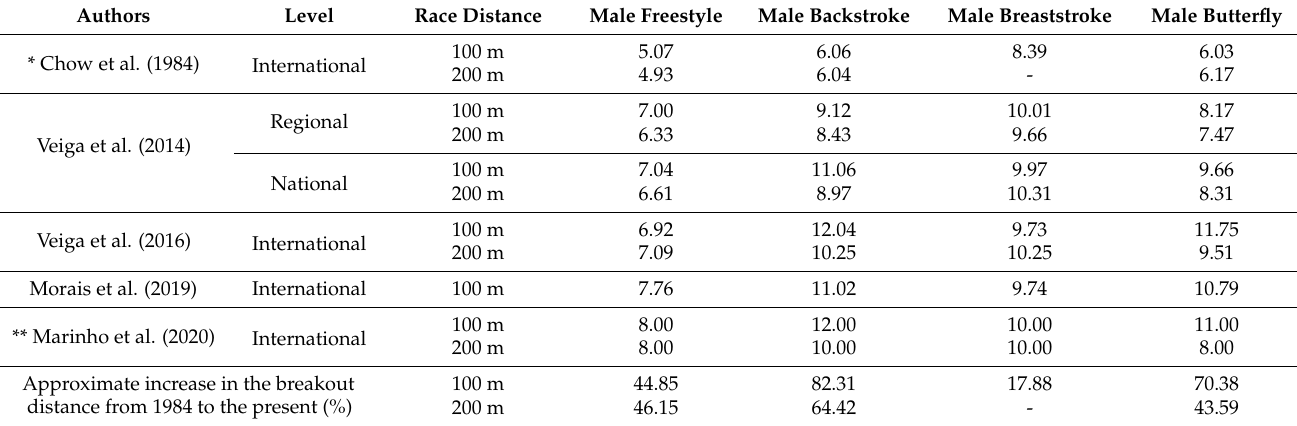
Table 4. Breakout distance after the turn in the four swimming strokes in 1984 and recent years in male events (the numbers in the table only show the mean value presented in each study).